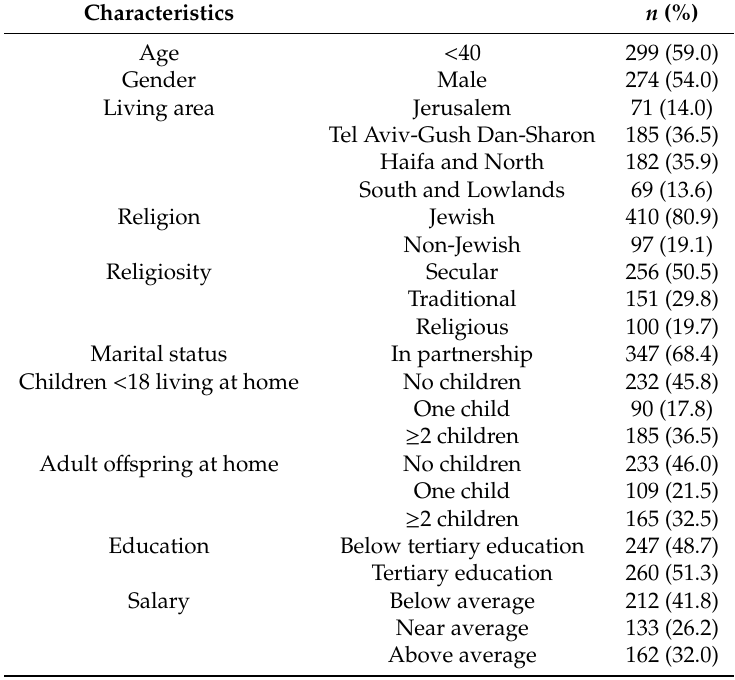
Table 1. Characteristics of respondents to questionnaire ( n =